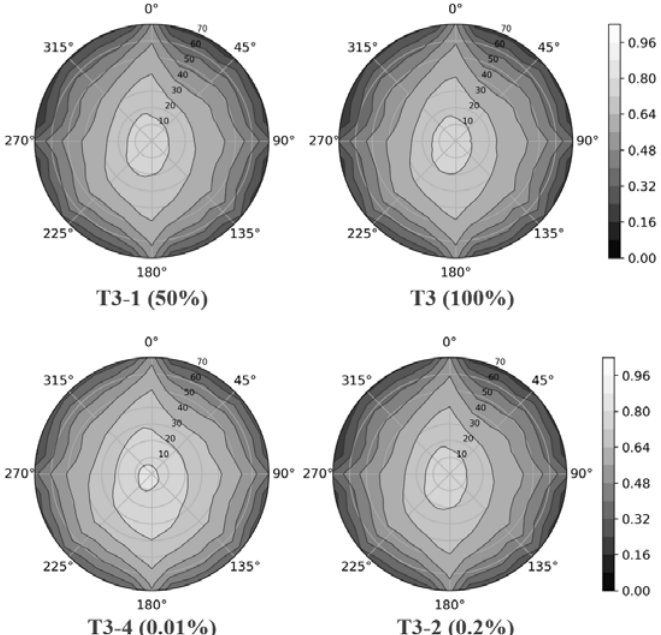
Figure 9. Gap fraction polar contour diagrams for the second stage (25 September 2019).